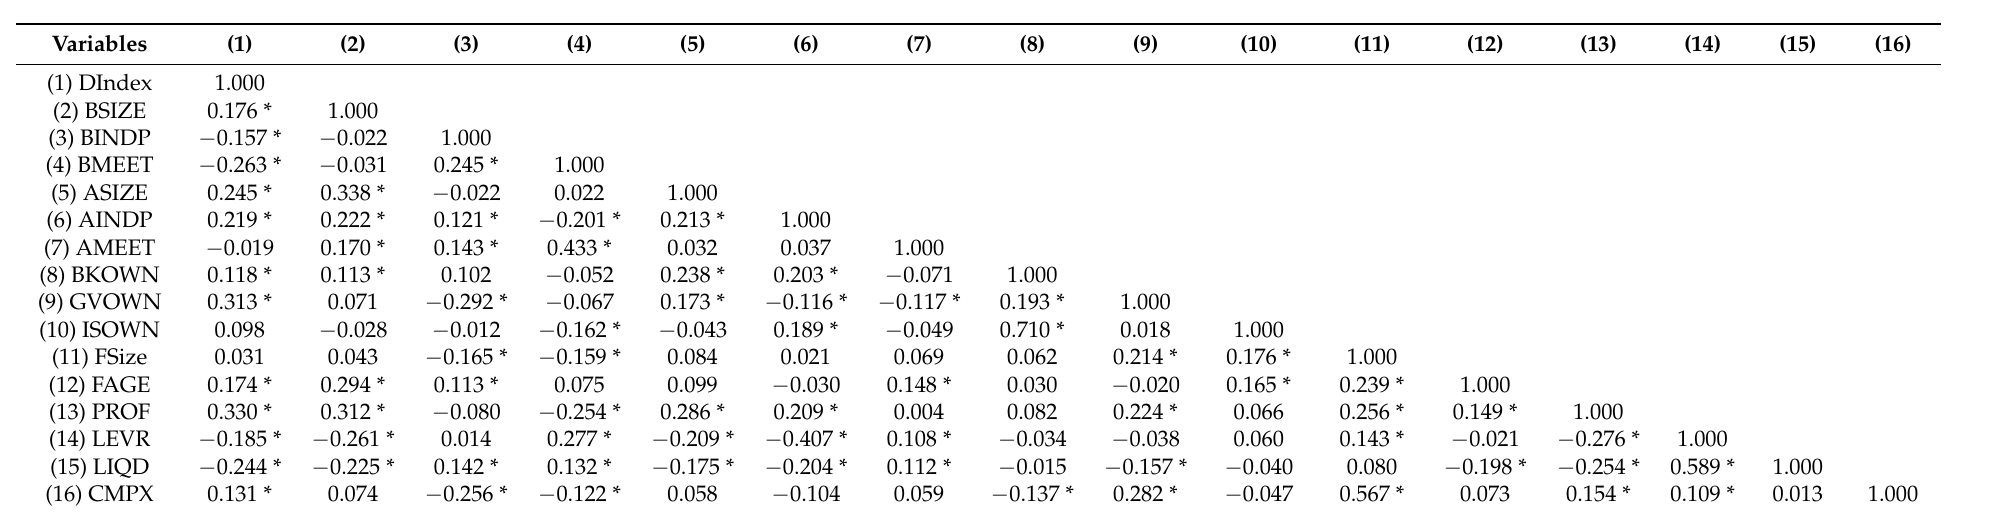
Table 4. Pairwise